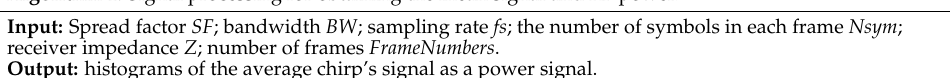
Algorithm 1. Signal processing for obtaining the mean signal and RF